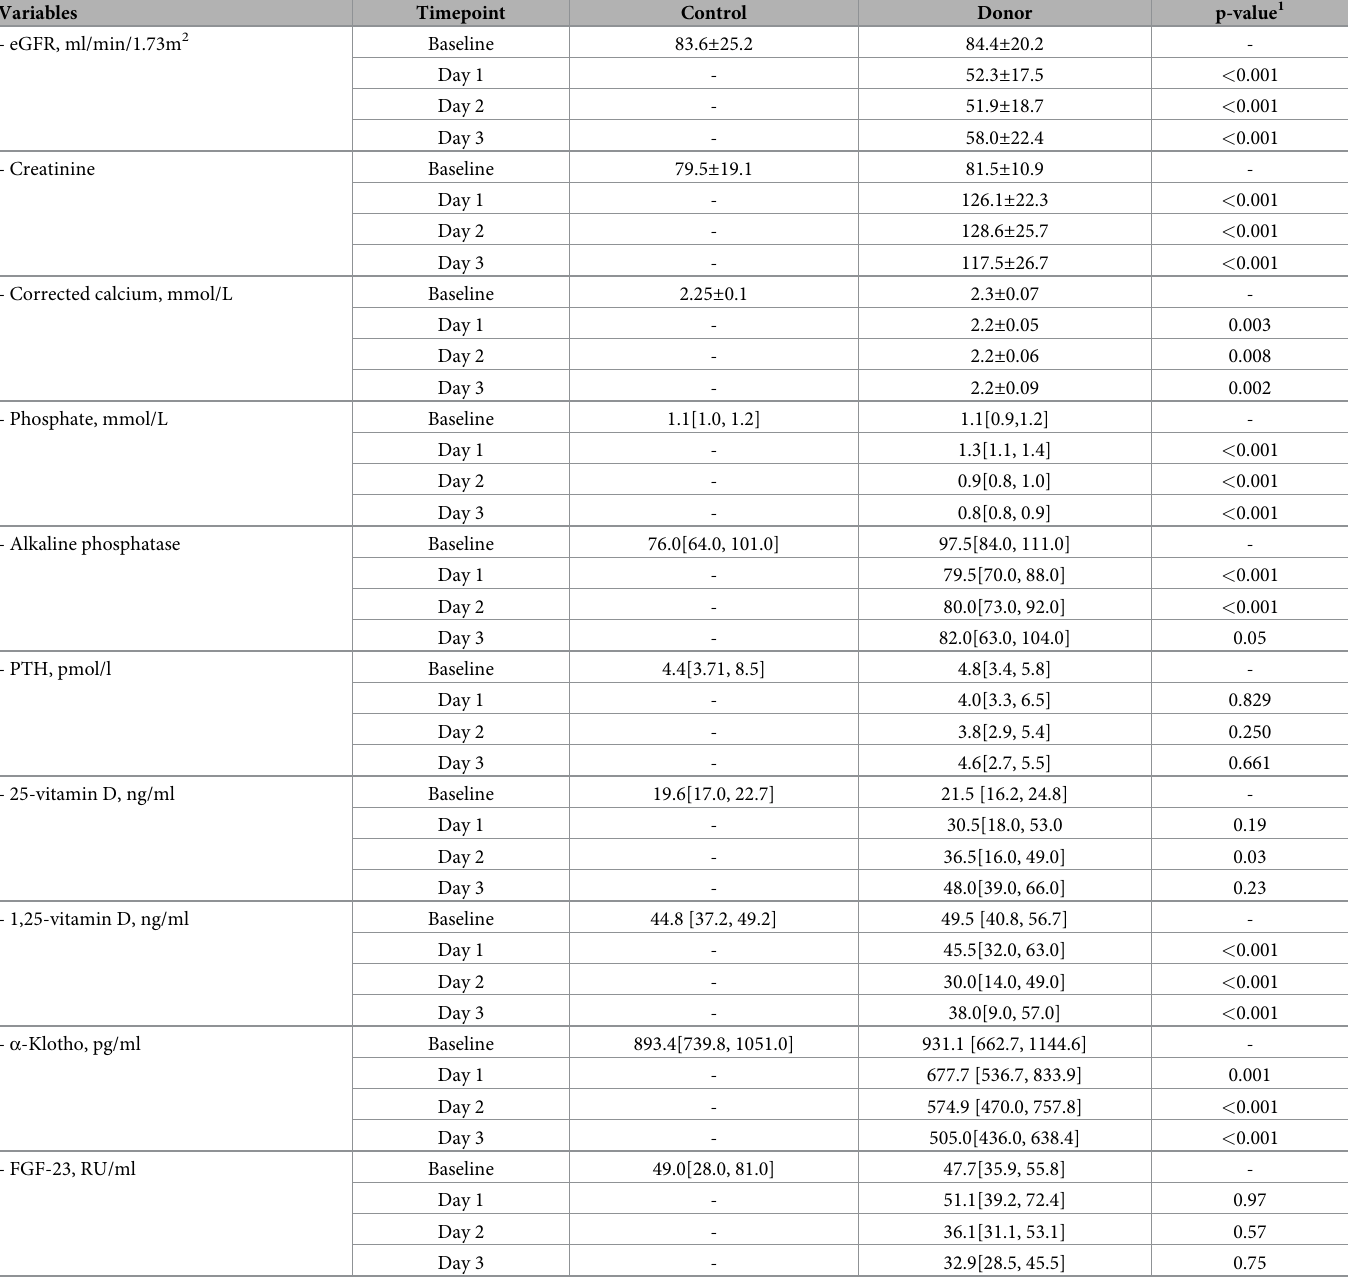
Table 2. Laboratory measurements in the acute period after kidney